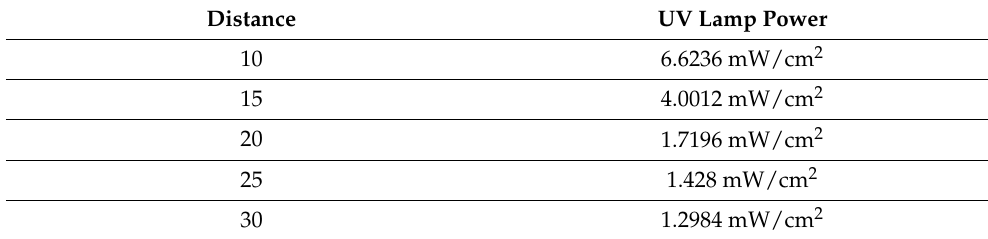
Figure 13. Microwave-driven UV lamp block diagram. Table 5. Comparison of UV lamp power with distances.